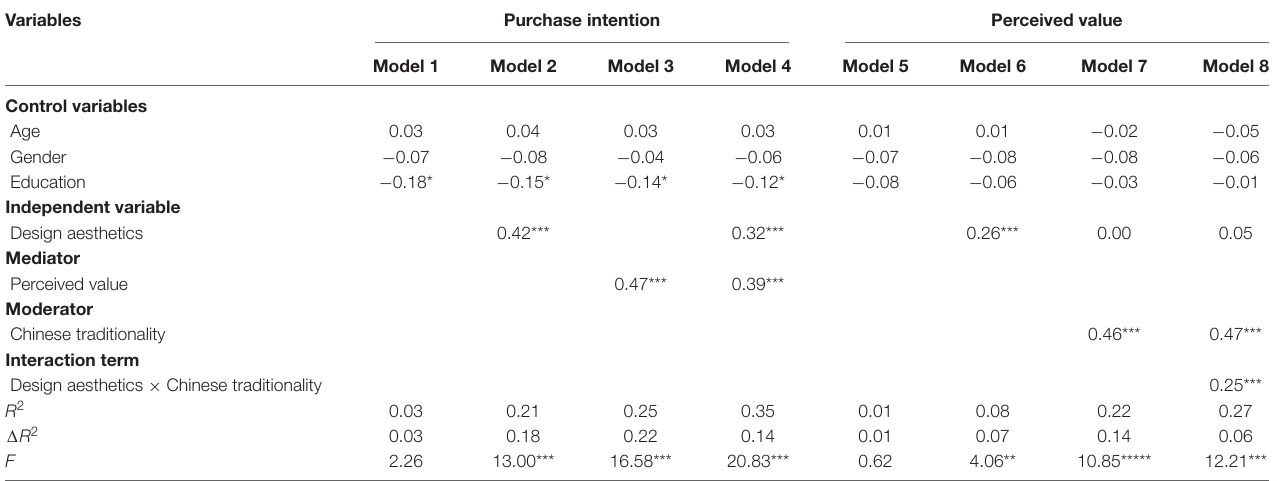
TABLE 3 | Results of the moderated regression